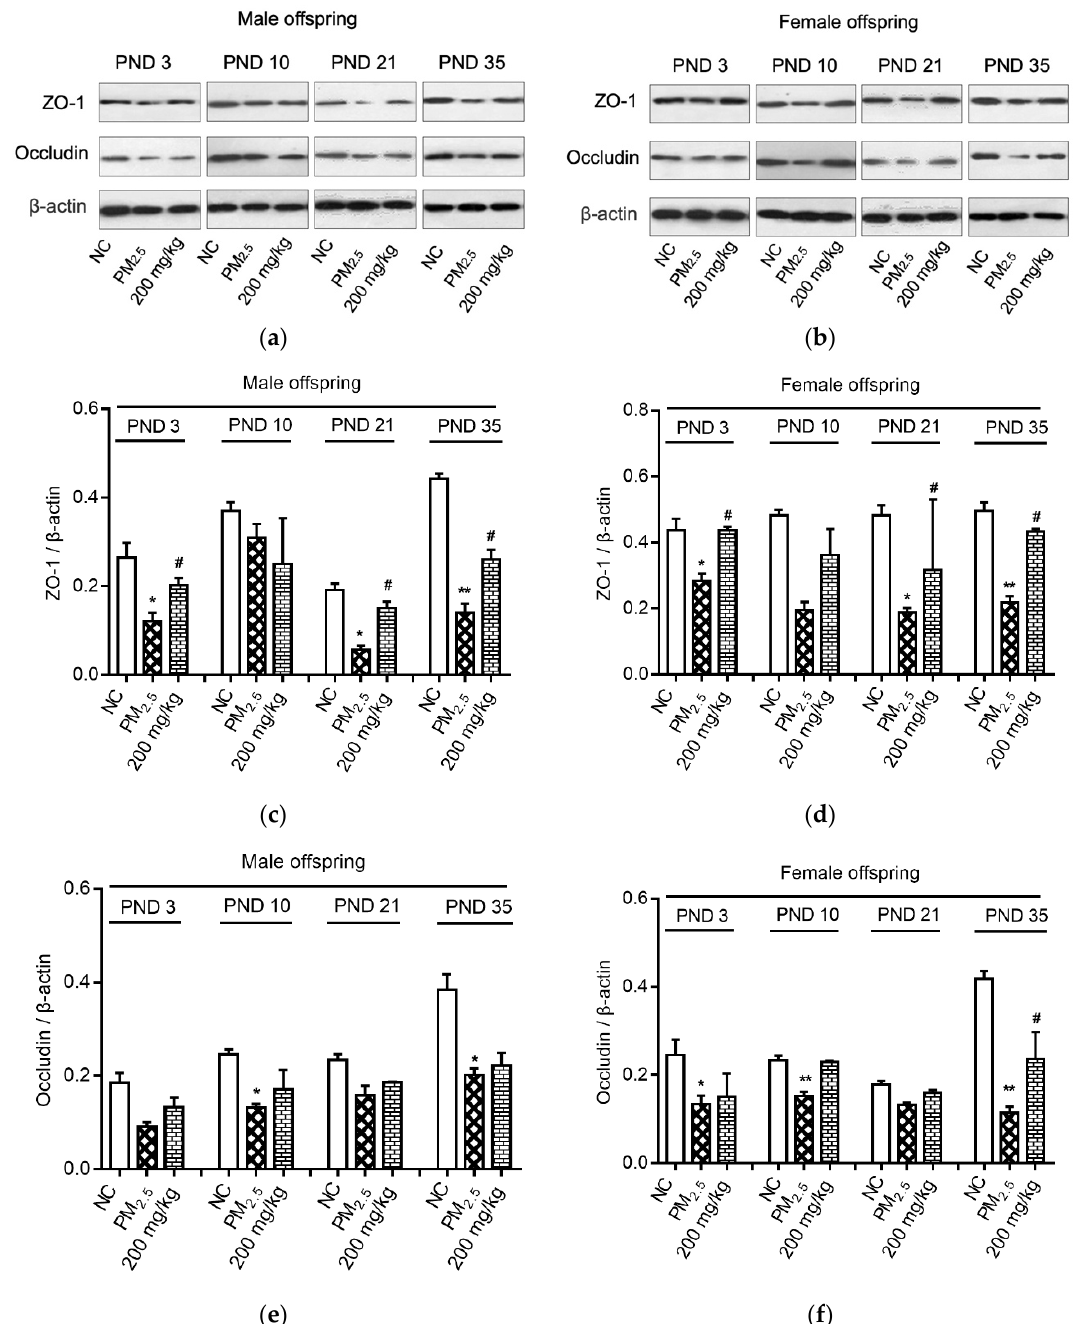
Figure 4. Effects on proteins of colon. ( a ) Immunoblots of ZO-1 and occludin expression of male offspring; ( b ) Immunoblots of ZO-1 and occludin expression of female offspring; ( c ) ZO-1 expressions of male offspring; ( d ) ZO-1 expressions of female offspring; ( e ) Occludin expressions of male offspring; ( f ) Occludin expressions of female offspring. Compared with the NC group, * indicates p < 0.05, ** indicates p < 0.01. Compared with the PM 2.5 group, # indicates p < 0.05. The values were normalized against the intensity of β -actin, n = 3/group/gender/time.